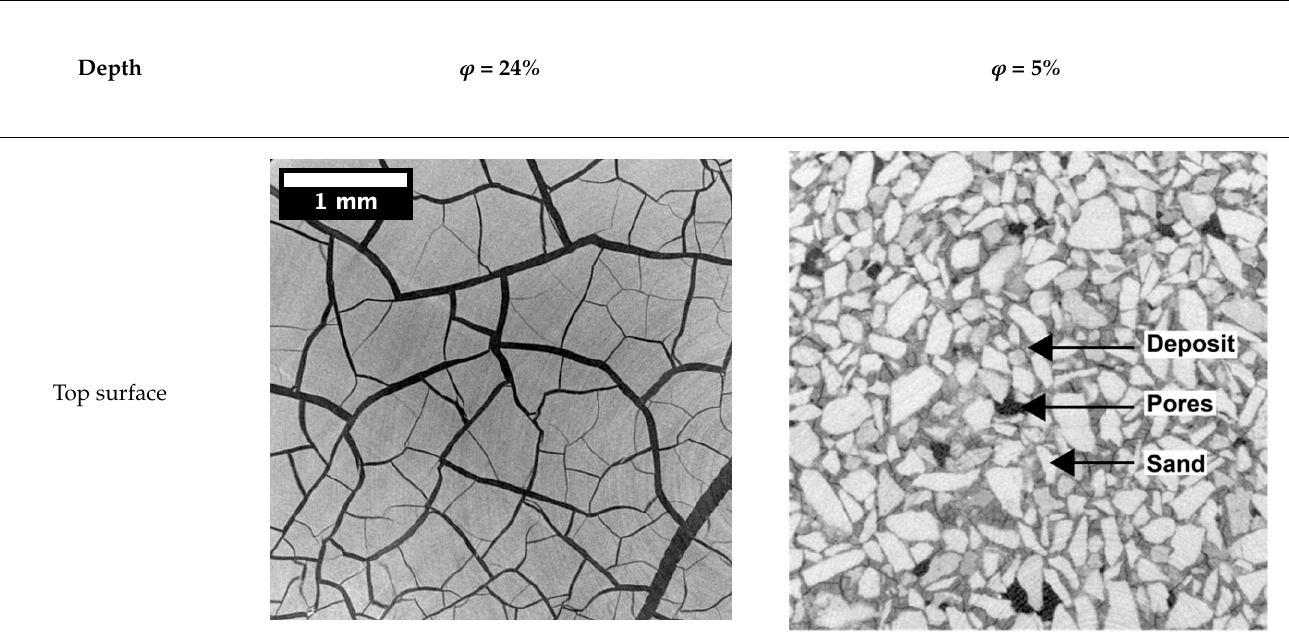
Table 2. Microtomography images, perpendicular to the main axis of the cylindrical samples, of the dried porous media with nanoparticle deposits. Left column: initial particle volume fraction ϕ = 24%; right column: initial particle volume fraction ϕ = 5%. All images have the same resolution, and the scale bar on the first image applies to all images. Depth ϕ = 24 % ϕ = 5 %